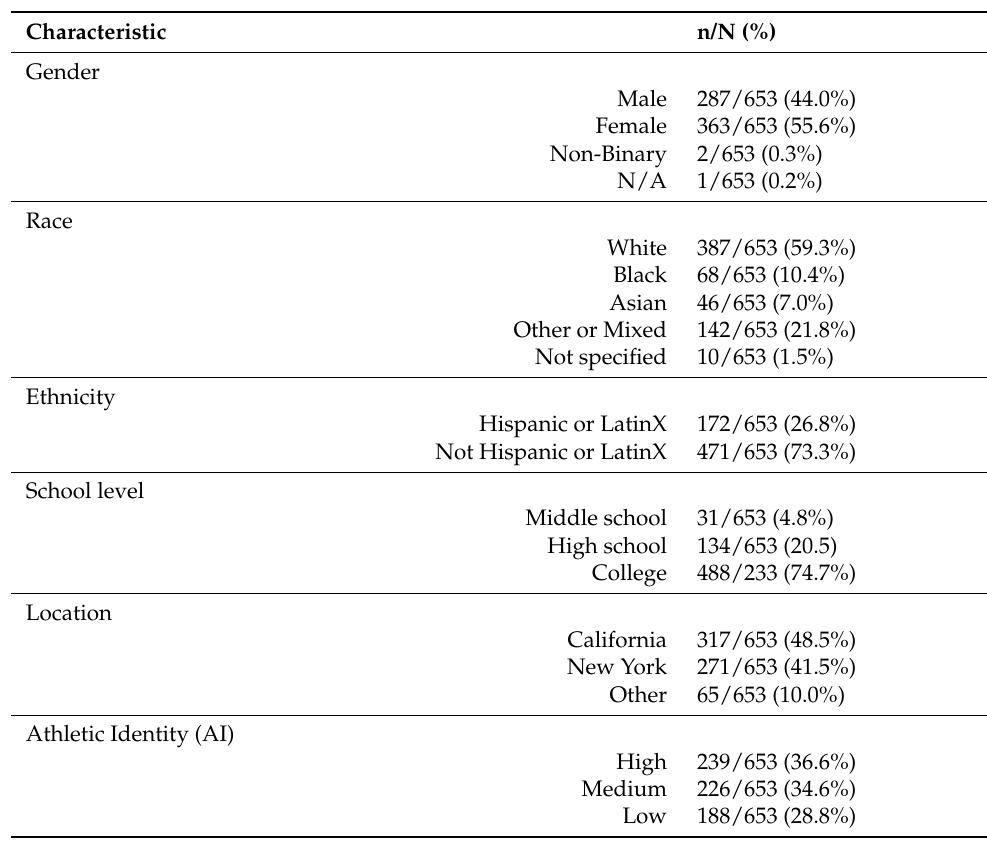
Table 1. Participant